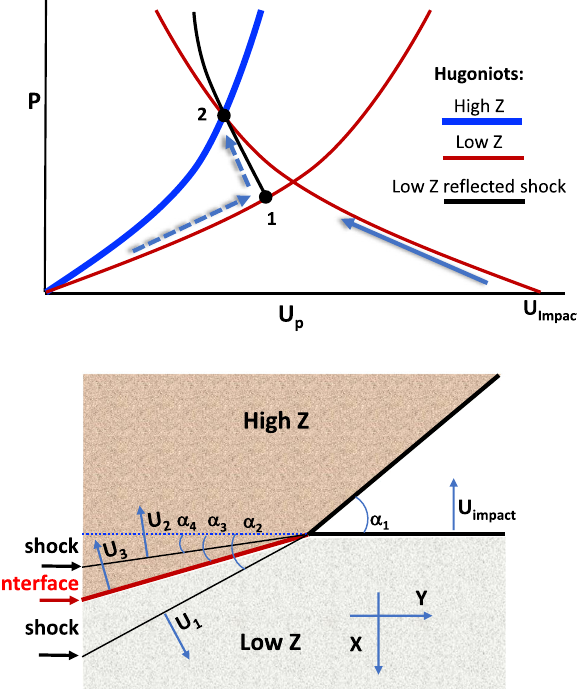
Fig. 2 Material loading paths, impact vs. shock. a Two paths are considered to reach the shocked state (2) of the high-impedance material (blue curve): (i) impact by a lower-impedance material at impact velocity U fl ected shock through point 1 (dashed arrows) impact (solid arrow); or (ii) re b Tilting of the shock fronts and interface are illustrated for a projectile with velocity ( U i mpact ) impacting a wavy surface target at a local oblique angle ( α 1 ). All angles are de fi ned to be